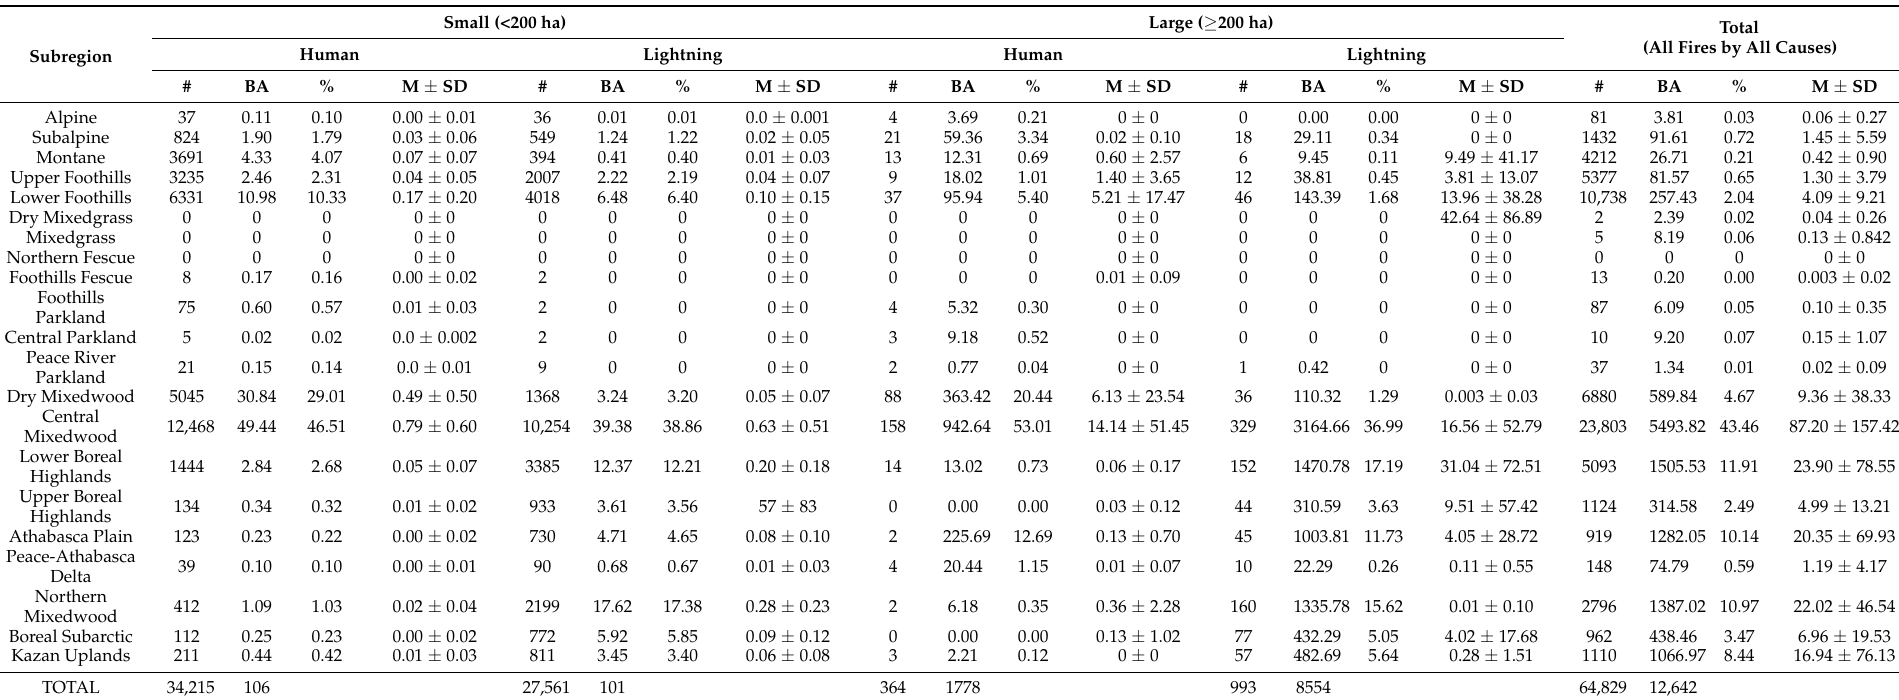
Table 2. Total number of forest fire occurrences (#), total burned area (BA, in 1000 ha), percent of total BA (%), and mean ± standard deviation (M ± SD in thousand ha) by small and large forest fires caused by human and lightning in the subregions of Alberta during